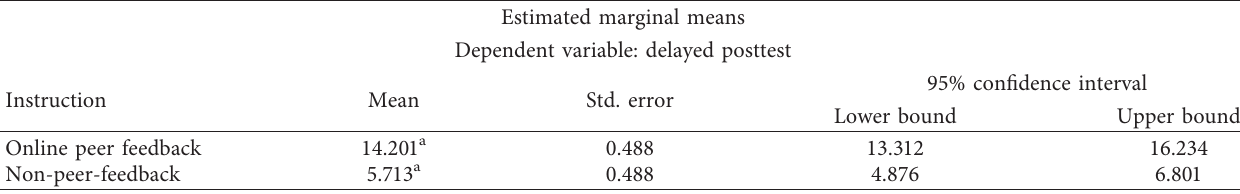
Table 9: Estimated marginal means.